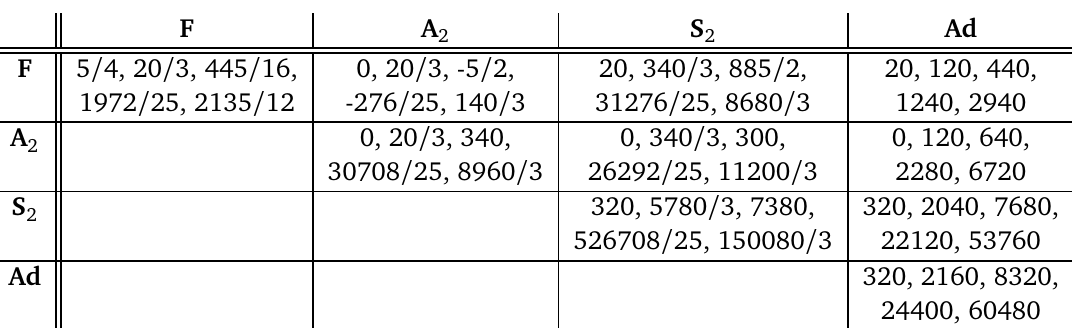
Table 7: The numerical values of d abcd ( R ( F ) = 1. For the “physicist” normalization l with the choice l 2 value by 1 /